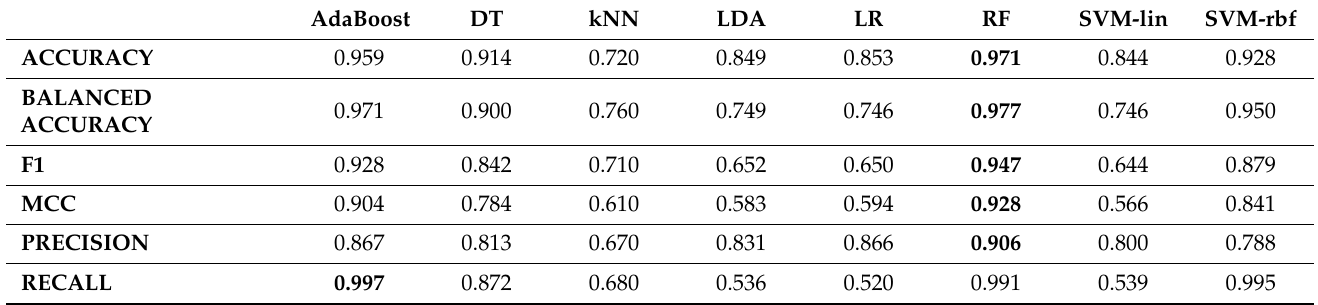
Table 3. Metrics for performance evaluation of the session-independent approach (for each metric, the best performance results are identified in bold).